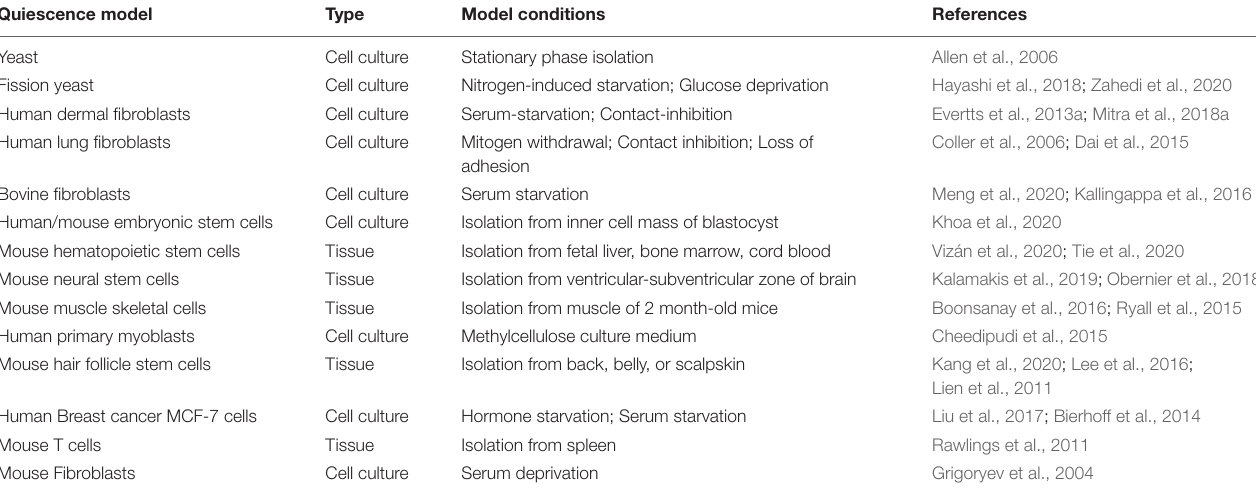
TABLE 1 | List of in vitro and in vivo quiescence